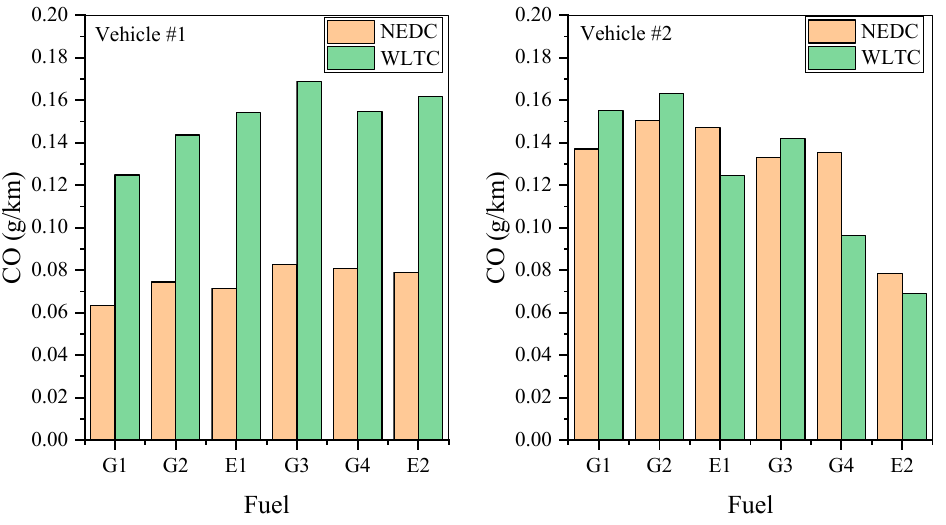
Figure 4. Specific CO emission for the six fuels.